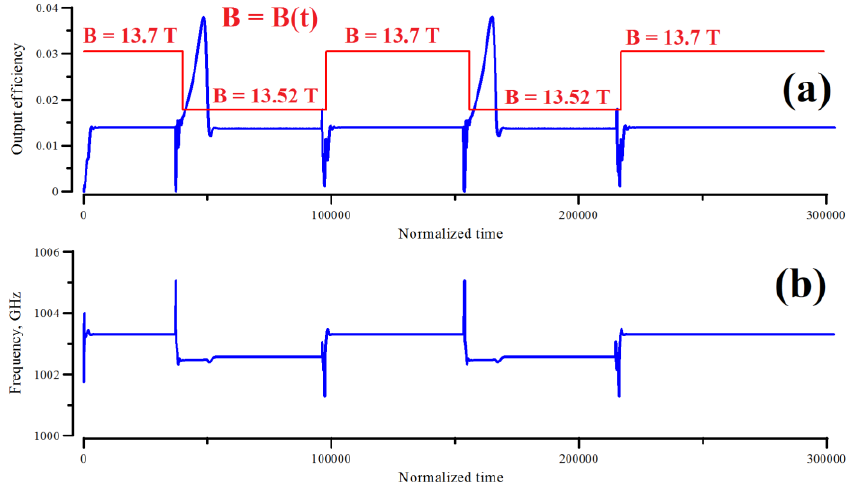
Fig. 2. (a) Dynamics of excitation of a gyrotron with a sectioned cavity when switching the operating magnetic field. The dependence of the magnetic field on time is shown schematically (red lines). (b) Dependence of the generation frequency on the normalized time with a varying magnetic field.